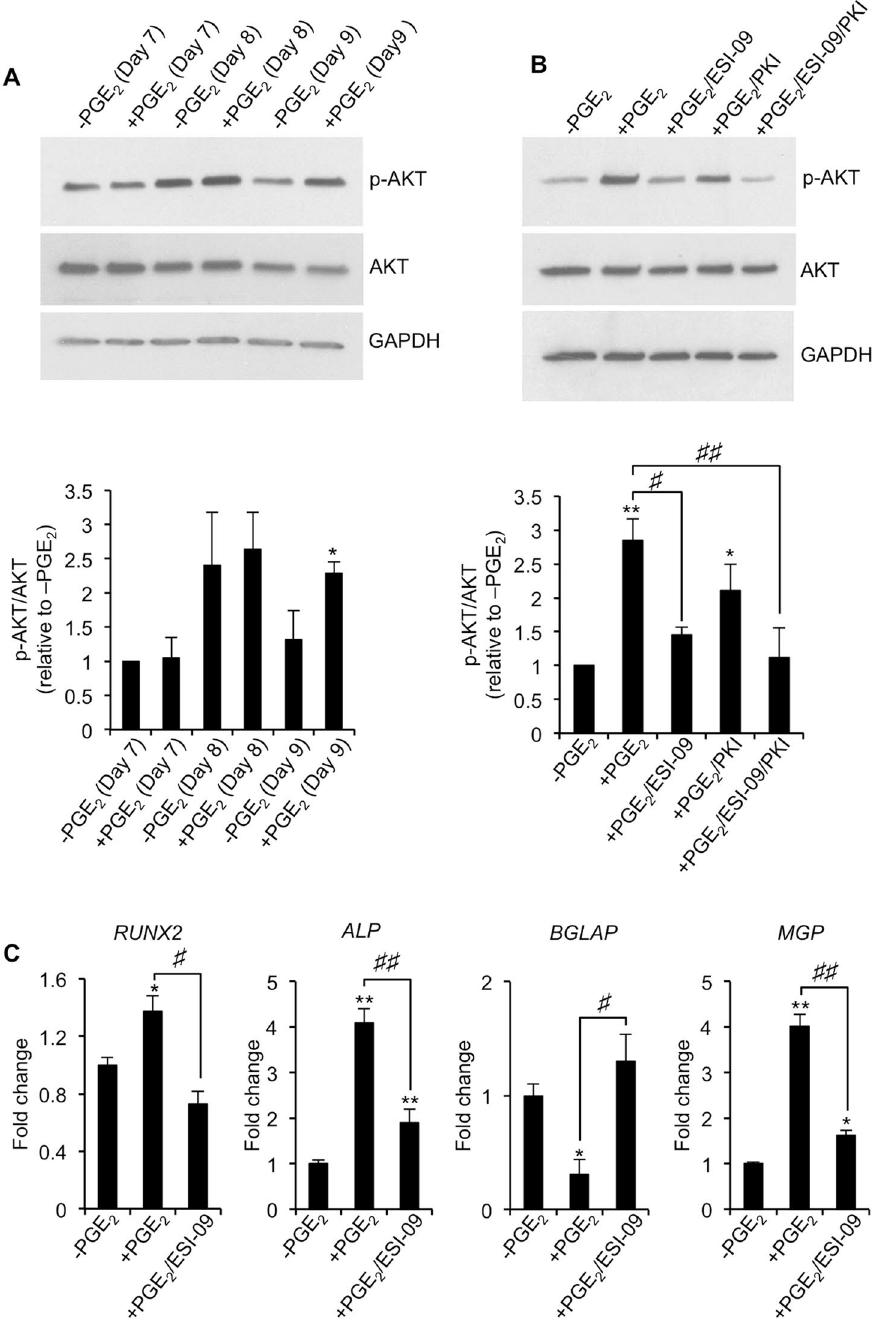
Figure 7. PGE 2 activates AKT in an Epac-dependent manner. ( A ) hBMSCs were cultured continuously in the absence ( − PGE 2 ) or presence ( + PGE 2 ) of PGE 2 (10 nM), and AKT phosphorylation levels determined by Western blot analysis at day 7, 8 and 9. * p < 0.01 as compared to − PGE 2 using Student’s t-test. ( B ) hBMSCs were cultured continuously in the absence ( − PGE 2 ) or presence ( + PGE 2 ) of PGE 2 (10 nM) with or without Epac inhibitor ESI-09 (10 μ M) or PKA inhibitor PKI (10 μ M), and AKT phosphorylation levels determined by Western blot analysis at day 9. * p < 0.01, ** p < 0.001 as compared to -PGE 2 using ANOVA. # p < 0.01, ## p < 0.001 using ANOVA. In both cases, GAPDH served as a loading control and representative cropped blots shown. ( C ) hBMSCs were cultured continuously in the absence ( − PGE 2 ) or presence ( + PGE 2 ) of PGE 2 (10 nM) with or without Epac inhibitor ESI-09 (10 μ M), and RUNX2 , ALP , BGLAP and MGP expression levels determined by RT-qPCR at day 17. * p < 0.05, ** p < 0.001 as compared to − PGE 2 using ANOVA. # p < 0.01, ## p < 0.001 using ANOVA. The data represent triplicate determinations and were replicated at least two times. All values are presented as mean ±